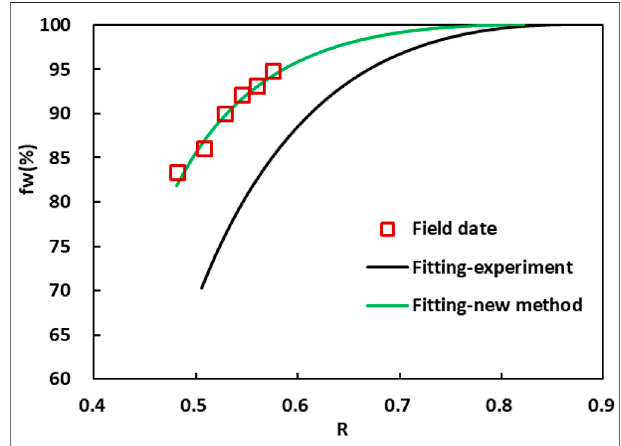
FIGURE 8 | The comparison of oil fi eld rising water-cut predicted by theoretical relative permeability curves or experiment relative permeability